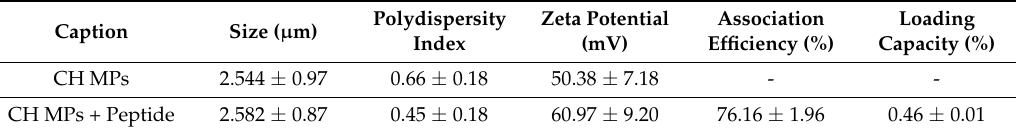
Table 1. Characteristics of unloaded CH MPs and peptide-loaded CH MPs (CH MPs + peptide) (mean ± sd ( n =